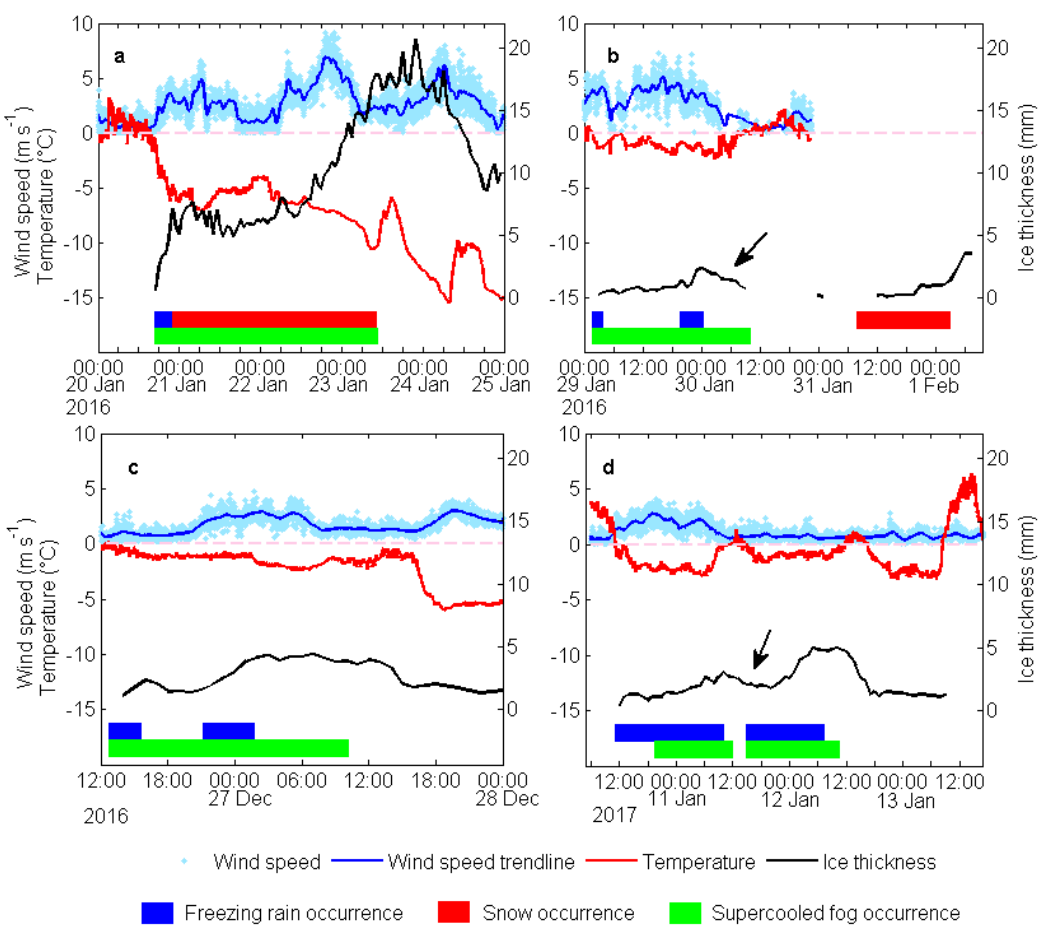
Figure 3. Temporal variations in ice thickness (black lines), air temperature (red lines), and wind speed (blue lines) in four icing cases: ( a ) case 1; ( b ) case 2; ( c ) case 3; and ( d ) case 4. Blue, red, and green rectangles indicate the occurrences of freezing rain, snow, and supercooled fog,